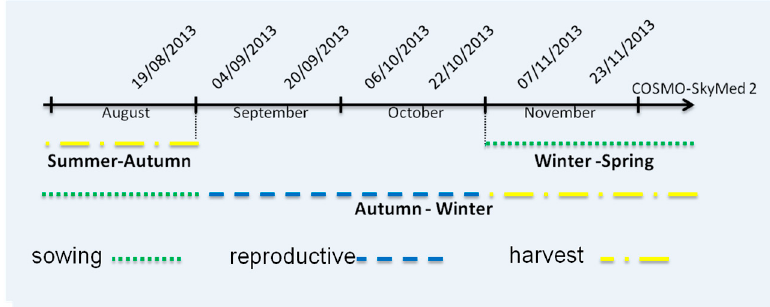
Figure 2. COSMO-SkyMed data available for the study and the rice crop calendar during this period in the An Giang Province.